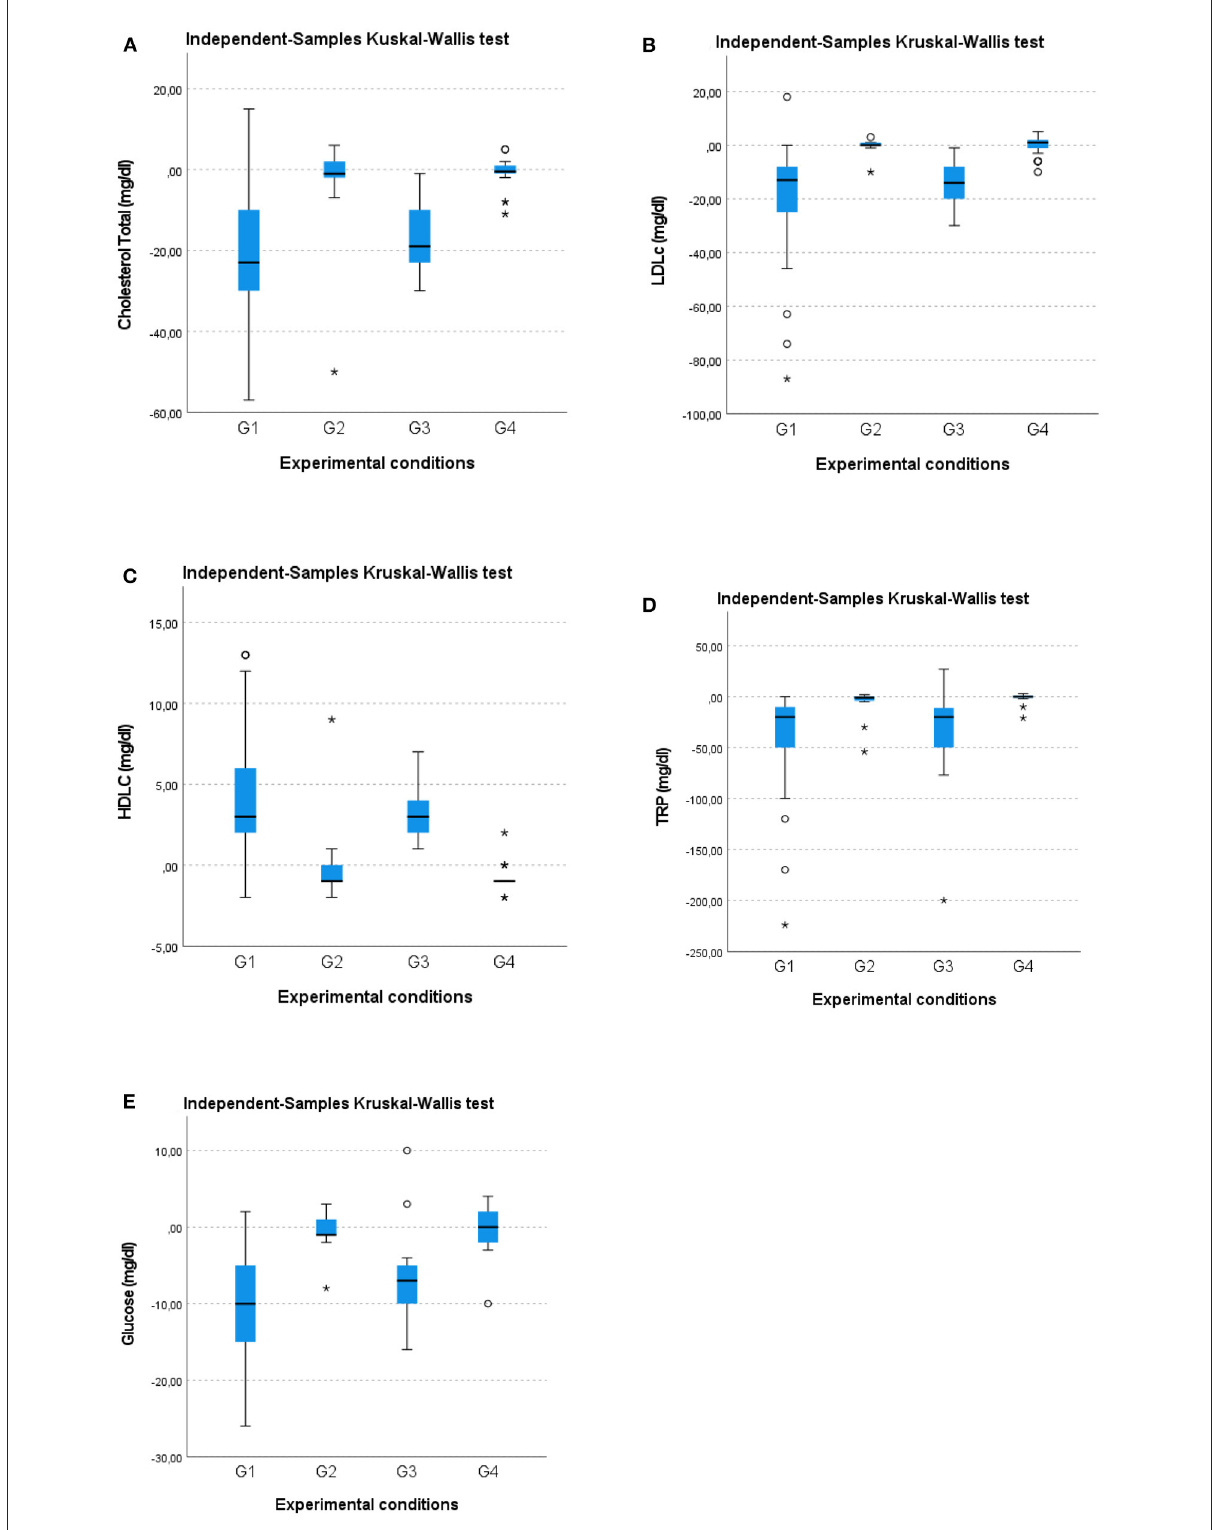
FIGURE4 Box-whisker plots showing (A) total cholesterol (mg/dl), (B) low-density lipoprotein cholesterol, LDLc (mg/dl), (C) high-density lipoprotein cholesterol, HDLc (mg/dl), (D) triglycerides, TRG (mg/dl), and (E) glucose (mg/dl) changes in the four groups at the 12-month follow-up (T1). O, Outliers; *,